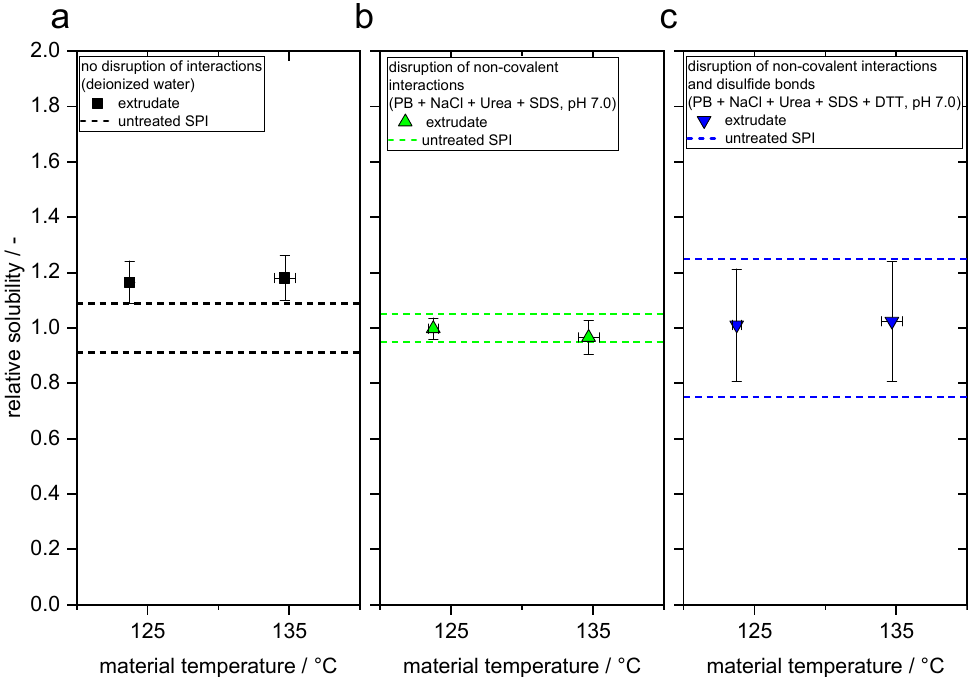
Figure 4. Relative solubility (sample solubility/raw material solubility) of the extrudates in different solvent systems as a function of temperature. From left to right: deionized water, non- reducing solvent and reducing solvent. PB = phosphate buffer, SDS = sodium dodecyl sulfate, DTT = dithiothreitol.